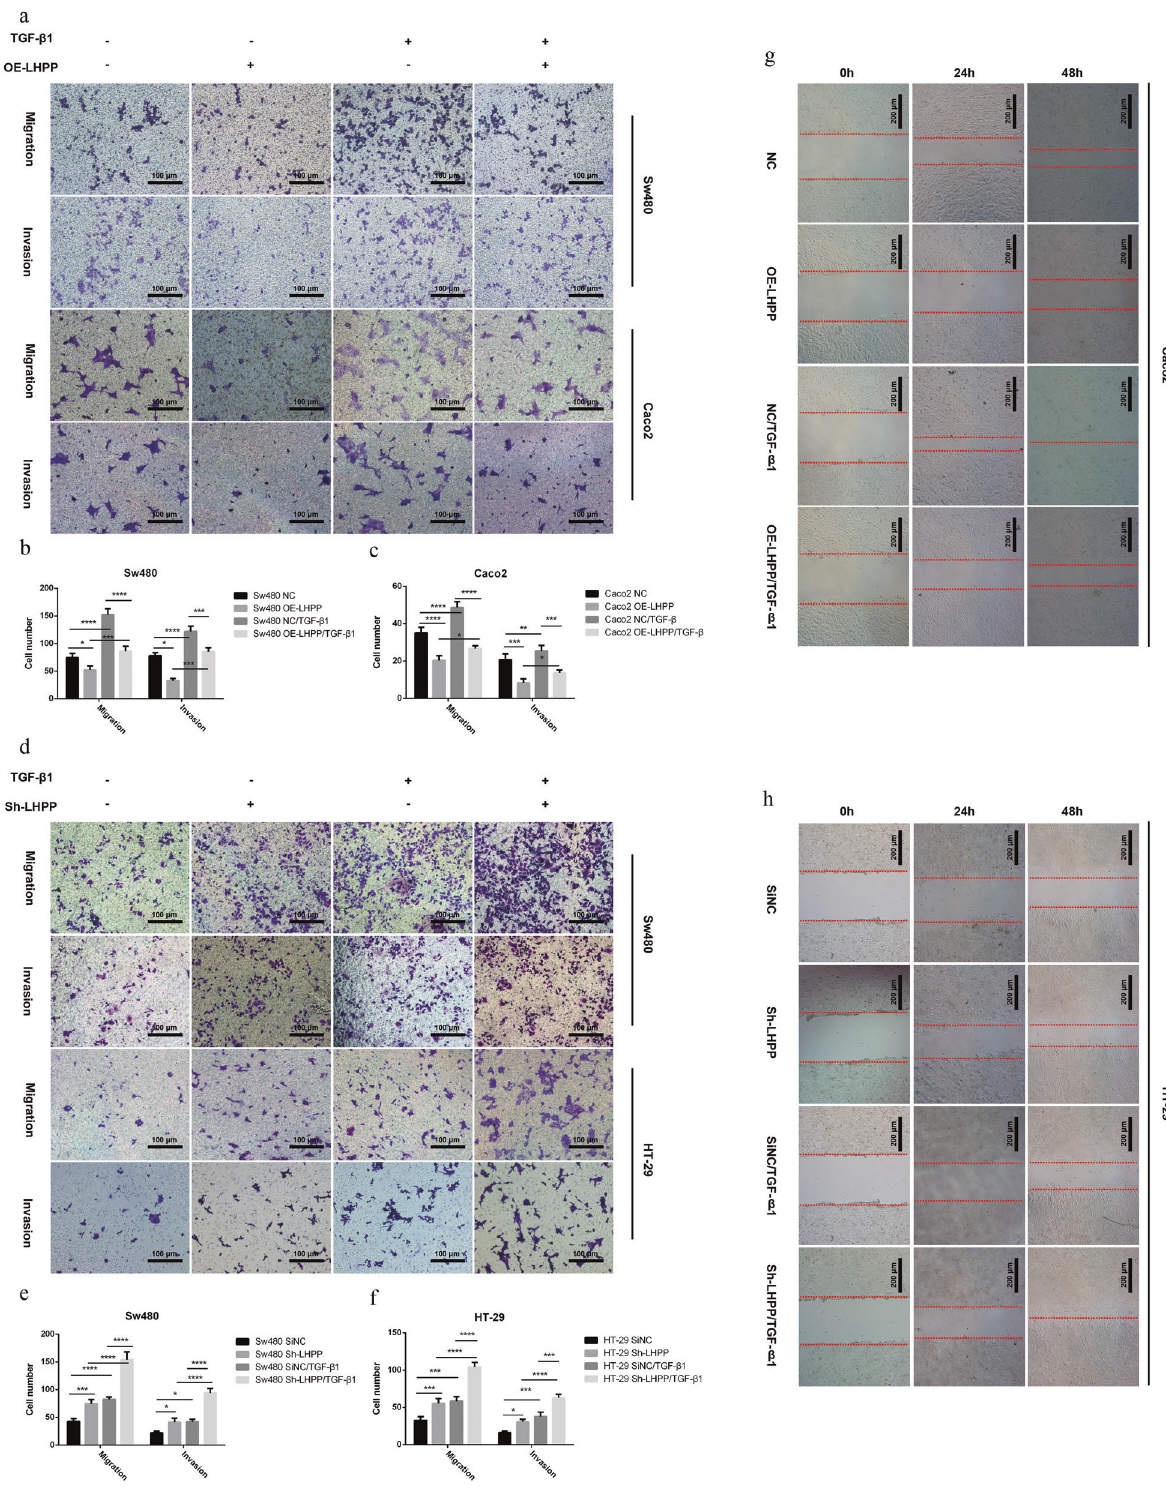
Fig. 4 The Transwell assay was performed to test migration and invasion (matrix gel 50 μ l, dilution 1:8, 8- μ m pore, scale bar, 100 μ m, ×100) abilities of colorectal cancer cells after TGF- β 1 stimulation (5 ng/ml) for 24 h. a Effect of LHPP overexpression on migration and invasion abilities of Sw480 and Caco2 cells. b , c The quanti fi cation results were calculated using the Graphpad Prism 6 software. Migration and invasion cells were stained and counted in at least fi ve microscope fi elds. d Silencing of LHPP expression promoted TGF- β 1-induced migration and invasion abilities in Sw480 and HT-29 cells. e , f The signi fi cant difference was determined using the Graphpad Prism 6 software. Migration and invasion cells were stained and counted in at least fi ve microscope fi elds. g , h We used wound-healing assay to verify the migration capability of Caco2 and HT-29 cell line after treating with TGF- β 1. The scratch was observed at 0, 24, and 48 h using microscope (scale bar, 200 μ m, ×40); * P < 0.05, ** P < 0.01, *** P < 0.001, **** P < 0.0001.